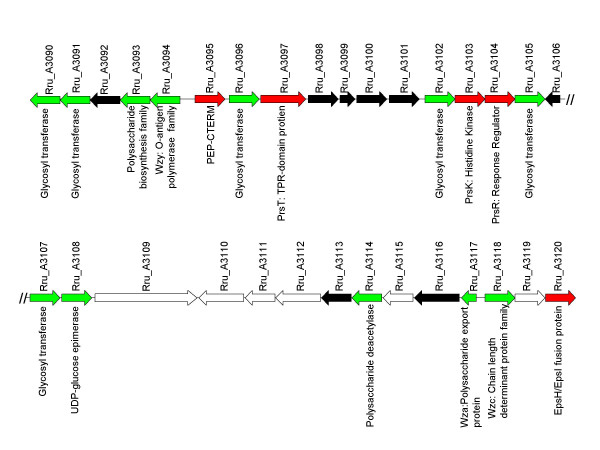
A 40 kilobase genomic region containing PEP-CTERM/EpsH system components and associated exopolysaccharide-related genes from Rhodospirillum rubrum. (Red = PEP-CTERM, Green = exopolysaccharide-related, Black = unknown functions, White = unrelated functions). Arrows show gene direction and relative size but are not to scale.